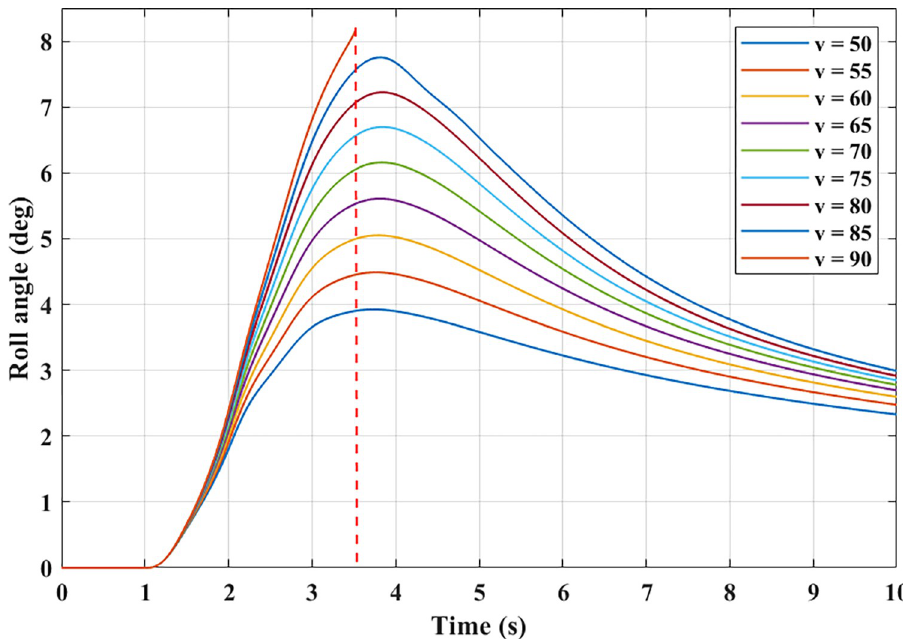
Fig 7. The relationship between velocity and roll